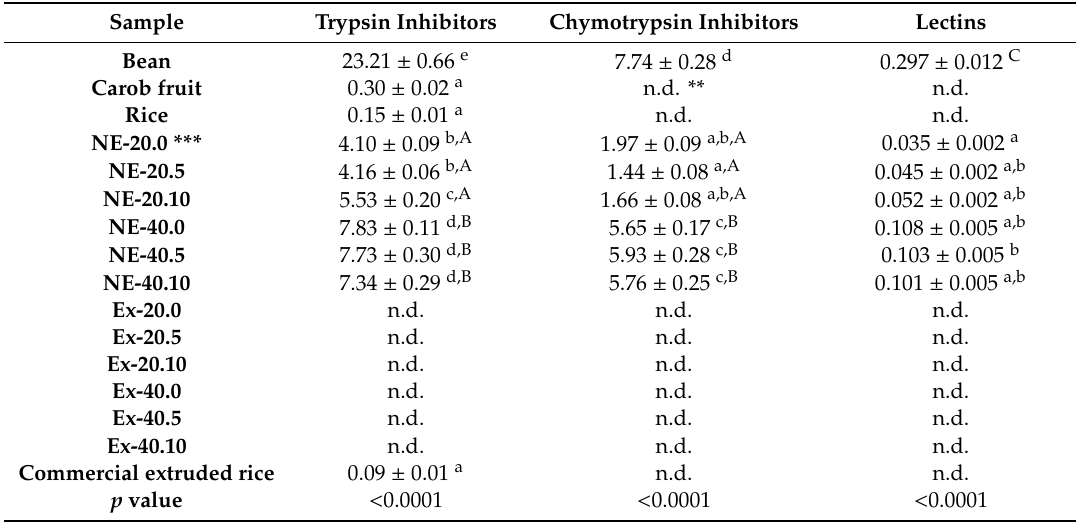
Table 3. E ff ect of extrusion treatment on trypsin inhibitors (TIU / mg dry weight), chymotrypsin inhibitors (CIU / mg dry weight), and lectin content (%PHA *) in raw materials, the non-extruded (NE-) and the extruded (Ex-) flour formulations, and the commercial sample.